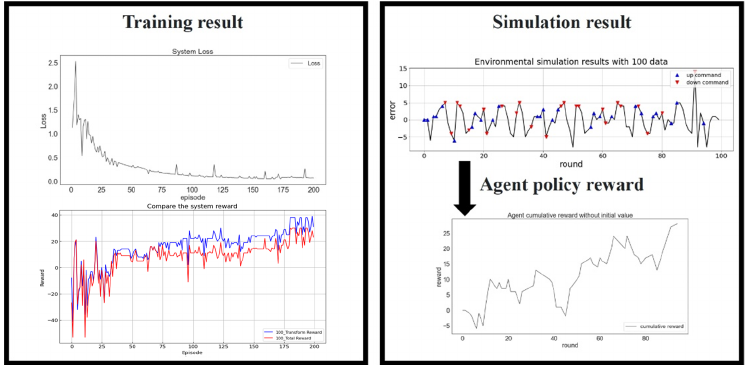
Figure 13. Training results for 100 data. Loss function ( top left ), reward ( bottom left ), simulated platform positioning ( top right ), and the agent policy reward ( bottom right ).